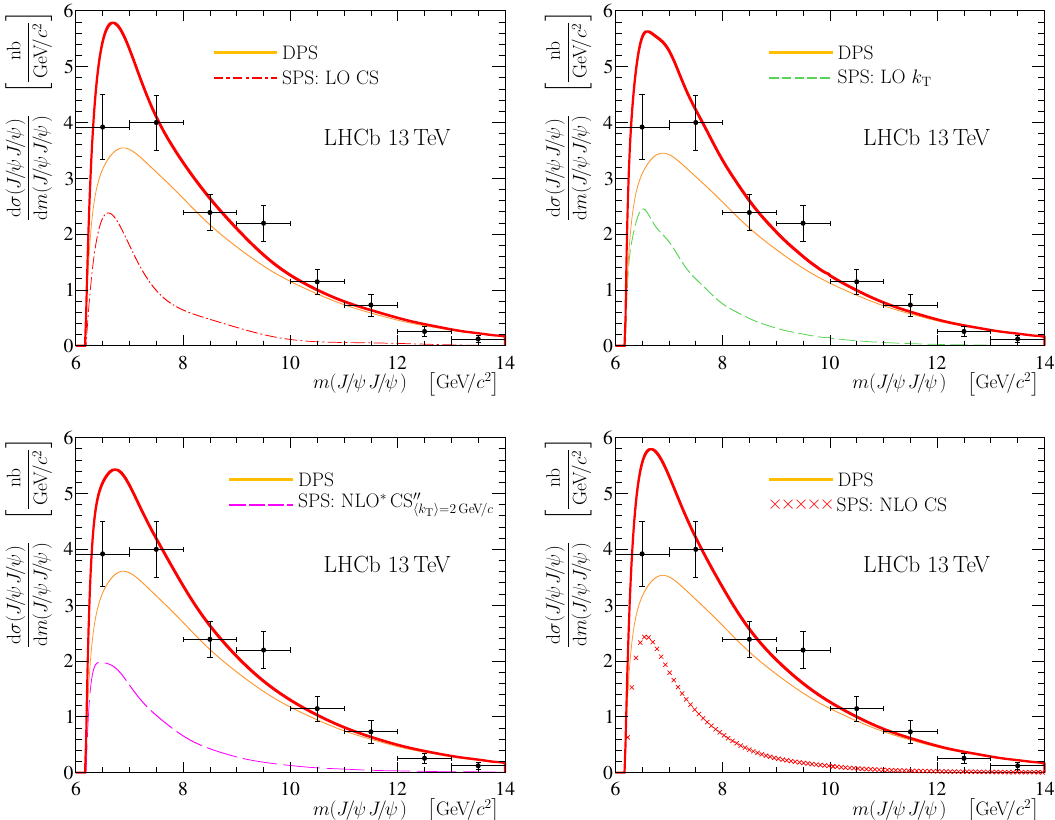
Figure 10. Result of templated DPS (cid:12)t for d (cid:27) ( J= J= ) . The (black) points with error bars represent d m ( J= J= ) the data. The total (cid:12)t result is shown with the thick (red) solid line and the DPS component is shown with the thin (orange) solid